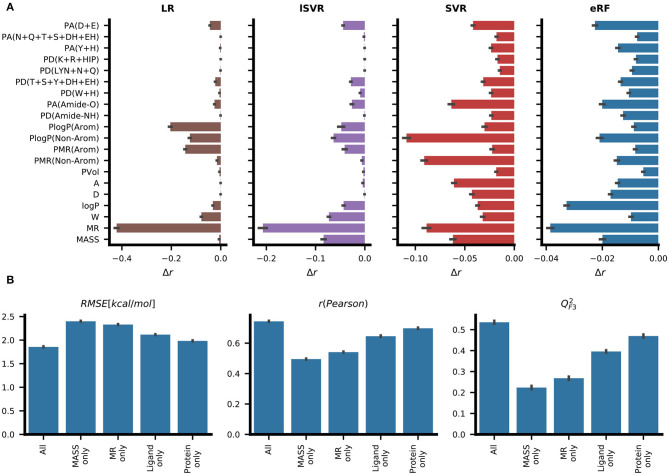
Analysis of feature importance for the predictive performance of RASPD+. (A) The average change in predictive performance as measured by Pearson correlation when the corresponding feature column was shuffled. Results are reported for linear regression (LR), linear support vector regression (lSVR), support vector regression (SVR), and extremely random forests (eRF). (B) Ablation based analysis entailing training eRF models with different feature sets. The models trained on just the values for molar refractivity (MR only) and molecular weight (MASS only) serve as lower bounds for measuring performance. The “ligand only” and “protein only” models trained on either only ligand or only protein features, respectively, perform better than the “MR only” and “MASS only” models but not as well as the models derived from all features. The protein features contain implicit information on the ligand size and this may indicate why the performance of the “protein only” model is better than that of the “ligand only” model (see Figure 1 for details).